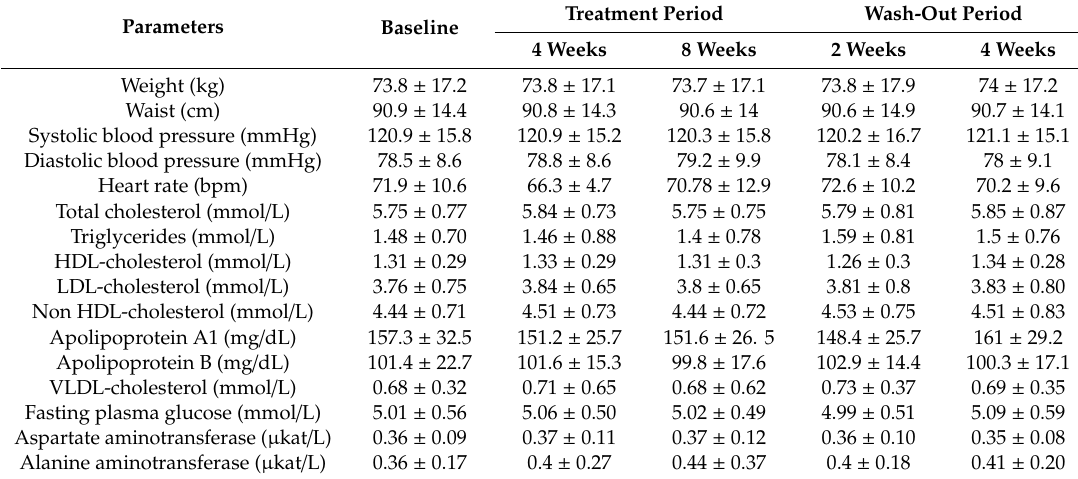
Table 4. Anthropometric, hemodynamic, and blood chemistry parameters from the baseline / end of wash-out to the end of the placebo sequence, expressed as mean ± SD.